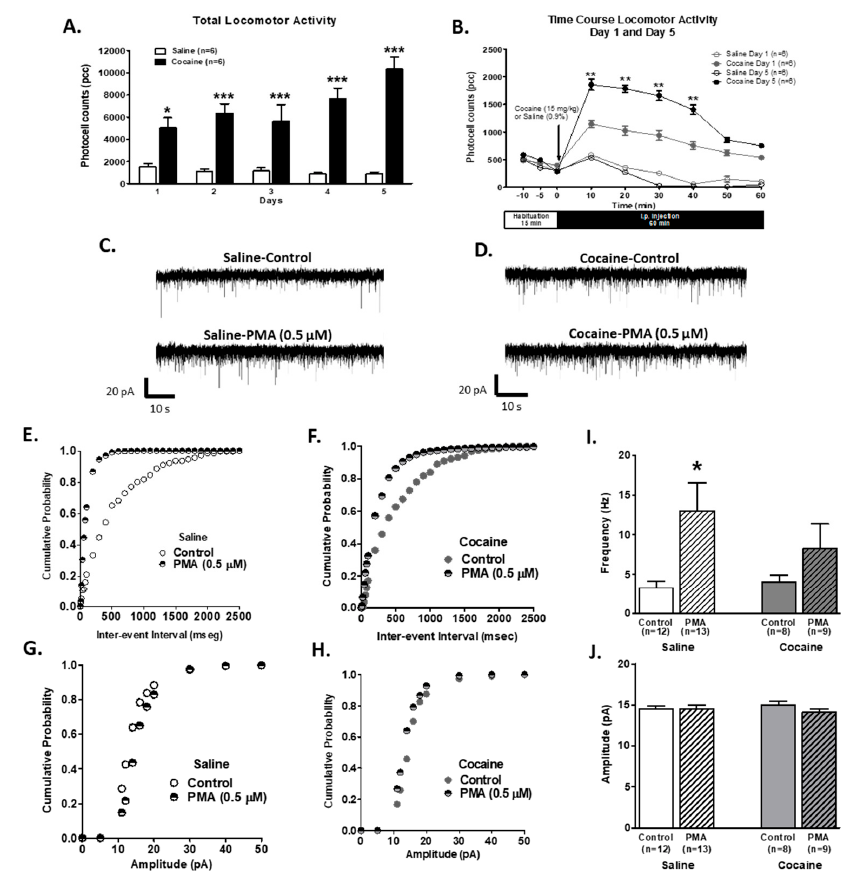
Figure 3. Phorbol 12-myristate 13-acetate ( PMA) pre-treatment on VTA DA neurons from cocaine-sensitized animals failed to increase sEPSCs frequency or amplitude. ( A ) The bar graph shows the total locomotor activity recorded from saline- (0.9%, white bars; n = 6) and cocaine- (15 mg/kg i.p., black bars; n = 6) treated animals. Cocaine-injected animals showed a progressive increase in locomotor activity over days. On day 5, total activity was significantly increased when compared to day 1 in cocaine-treated animals (Two-way repeated measures ANOVA, time F4,40 = 3.69, p < 0.05; treatment F1,40 = 78.72, p < 0.001). ( B ) The time course of locomotor activity on days 1 (grey) and 5 (black) of cocaine- (15 mg/kg, i.p.; filled; n = 6) or saline- (unfilled; n = 6) treated animals. Cocaine sensitization was manifested as an increase in locomotor activity during the first 40 min after cocaine injection in comparison with day 1. The data (pcc/60 min; Mean ± SEM) were analyzed by Two-way repeated measures ANOVA, time F8, 160 = 33.99, treatment F3,160 = 25.97, p < 0.001, Bonferroni post hoc test, p < 0.01. ( C ). Representative recordings from the neurons of saline-treated animals, illustrating that PMA pretreatment (0.5 μ M; 30 min) increases sEPSC frequency but not the amplitude. ( D ). Representative recordings from neurons of cocaine-sensitized animals illustrating that PMA pretreatment failed to increase the frequency or amplitude of sEPSCs. ( E ) and ( G ) The cumulative probability of the inter-event interval and amplitude cumulative distribution, respectively, from control- and PMA-treated neurons of saline-injected animals. Plots were constructed from the cells used in ( C , F , H ). The cumulative probability of inter-event interval and amplitude cumulative distribution (respectively) from control- and PMA-treated neurons of cocaine-sensitized animals. The plots were constructed from the cells used in ( D , I ). A summary graph showing that PMA treatment increased the mean sEPSC frequency in VTA DA cells from saline- ( n = 13/6) but not cocaine- ( n = 9/6) injected animals. ( J ) Summary graph shows that PMA treatment failed to increase the mean sEPSC amplitude in VTA DA cells from saline- ( n = 8/6) and cocaine- ( n = 9/6) injected animals. An unpaired t -test. * p < 0.05, ** p < 0.01, *** p < 0.001. n = the number of cells recorded/number of animals.